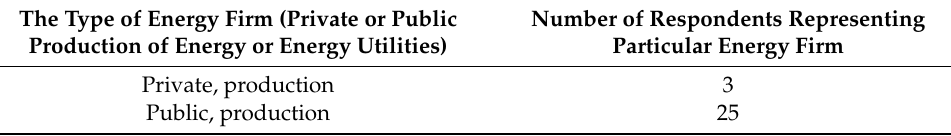
Table 1. Respondents from energy firms who participated in the study. The Type of Energy Firm (Private or